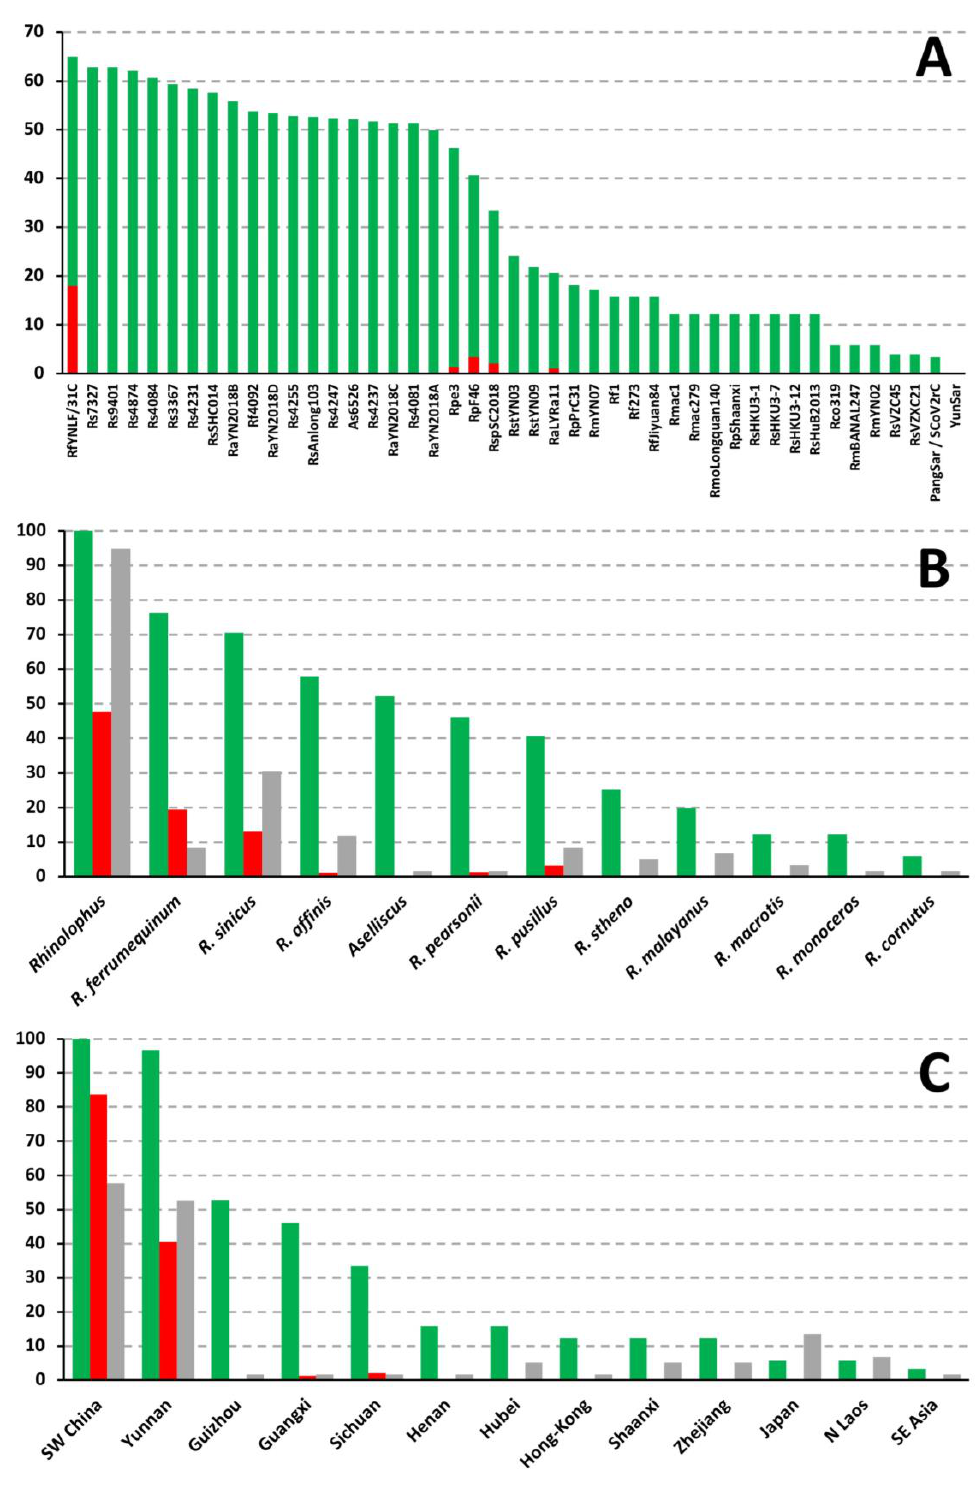
Figure 4. Percentages of whole-genome alignment including phylogenetic CGB barcodes (green histograms) shared between SARS-CoV and several bat sarbecoviruses ( A ) detected in different host taxa ( B , green histograms) and geographic regions ( C , green histograms). The red histograms indicate the percentages of exclusive ancestry found in bat sarbecoviruses ( A ), host taxa ( B ) and geographic regions ( C ). To assess sampling efforts, the grey histograms show the proportions of bat viruses used in our dataset for the host taxa and geographic regions of interest, respectively.